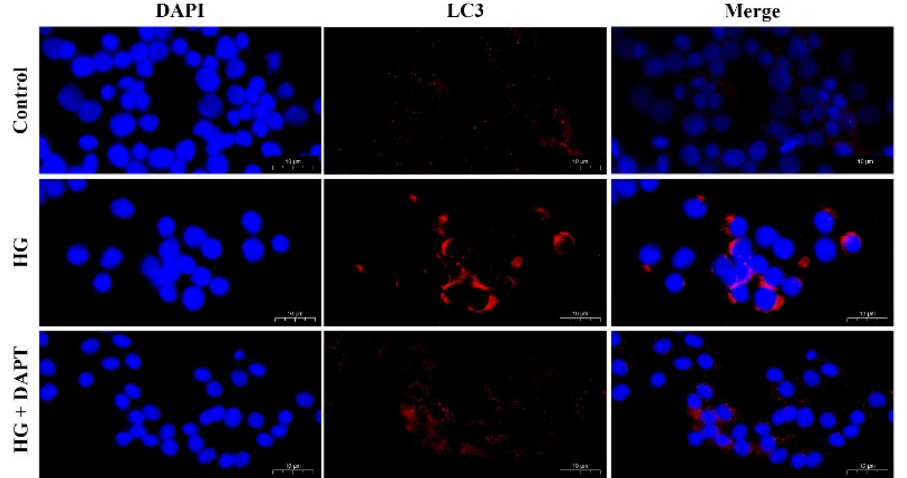
(Scale bar: 2 µm). ** p < 0.01 compared with control group; ##: p < 0.01.